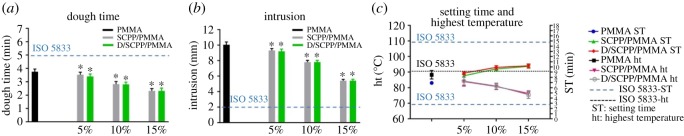
The dough time, intrusion, setting time and highest temperature of PMMA bone cement: (a) dough time; (b) intrusion; (c) setting time and highest temperature (*significant difference with PMMA group; p < 0.05).